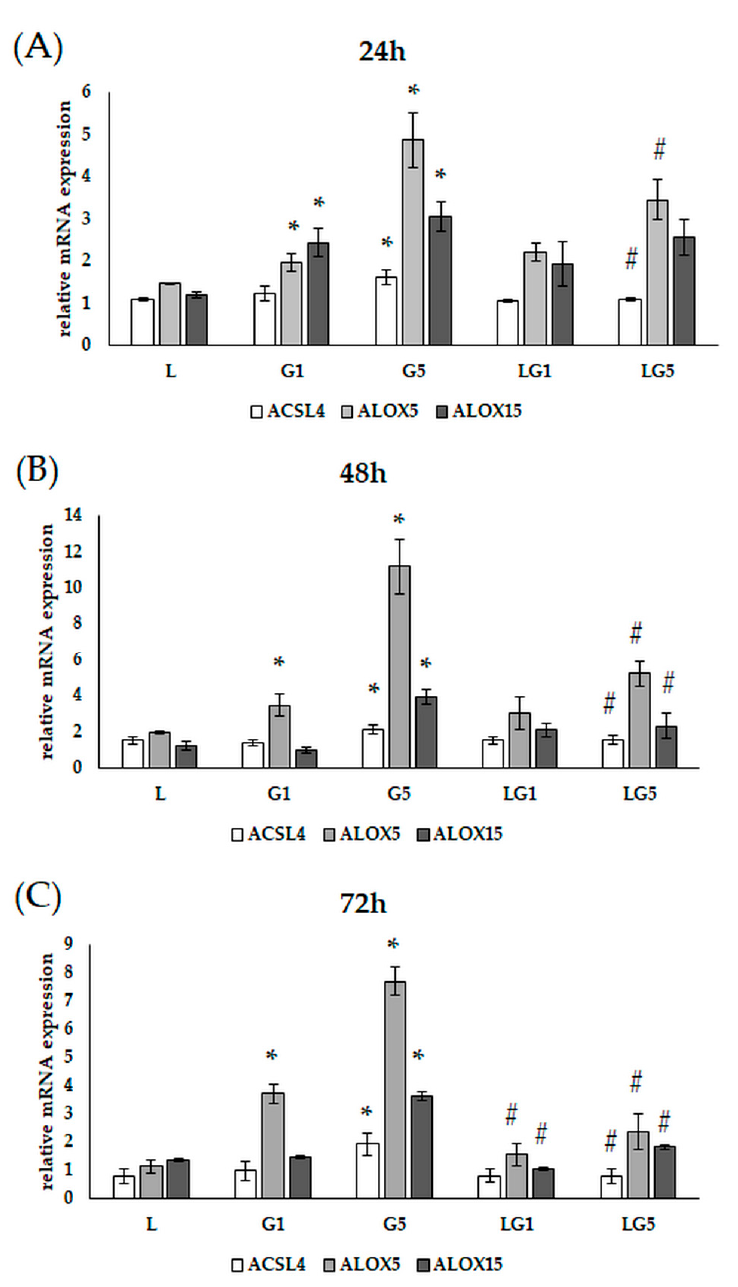
Figure 13. Determination of mRNA expression of ACSL4, ALOX5, and ALOX15 after lutein and Glu treatments of the SH-SY5Y cells at ( A ) 24 h ( B ) 48 h, and ( C ) 72 h. SH-SY5Y cells were treated with 10 ng/µL of lutein, 1 mM, 5 mM Glu, or lutein with Glu together to detect the changes in the expression of the examined genes. The gene expression measurements were performed by SYBR Green RT-PCR protocol using β -actin as a housekeeping gene. The relative expression of controls was regarded as 1. The bars represent the mean values (±standard deviation error bars, SD) of three independent experiments ( n = 3) performed in triplicate and are presented relative to their control cells. The * marks the statistical significance of Glu treatments compared to the control, # shows the statistical significance of combined (lutein with Glu) treatments compared to the Glu treatments at 24 h, 48 h, and 72 h ( p < 0.05).